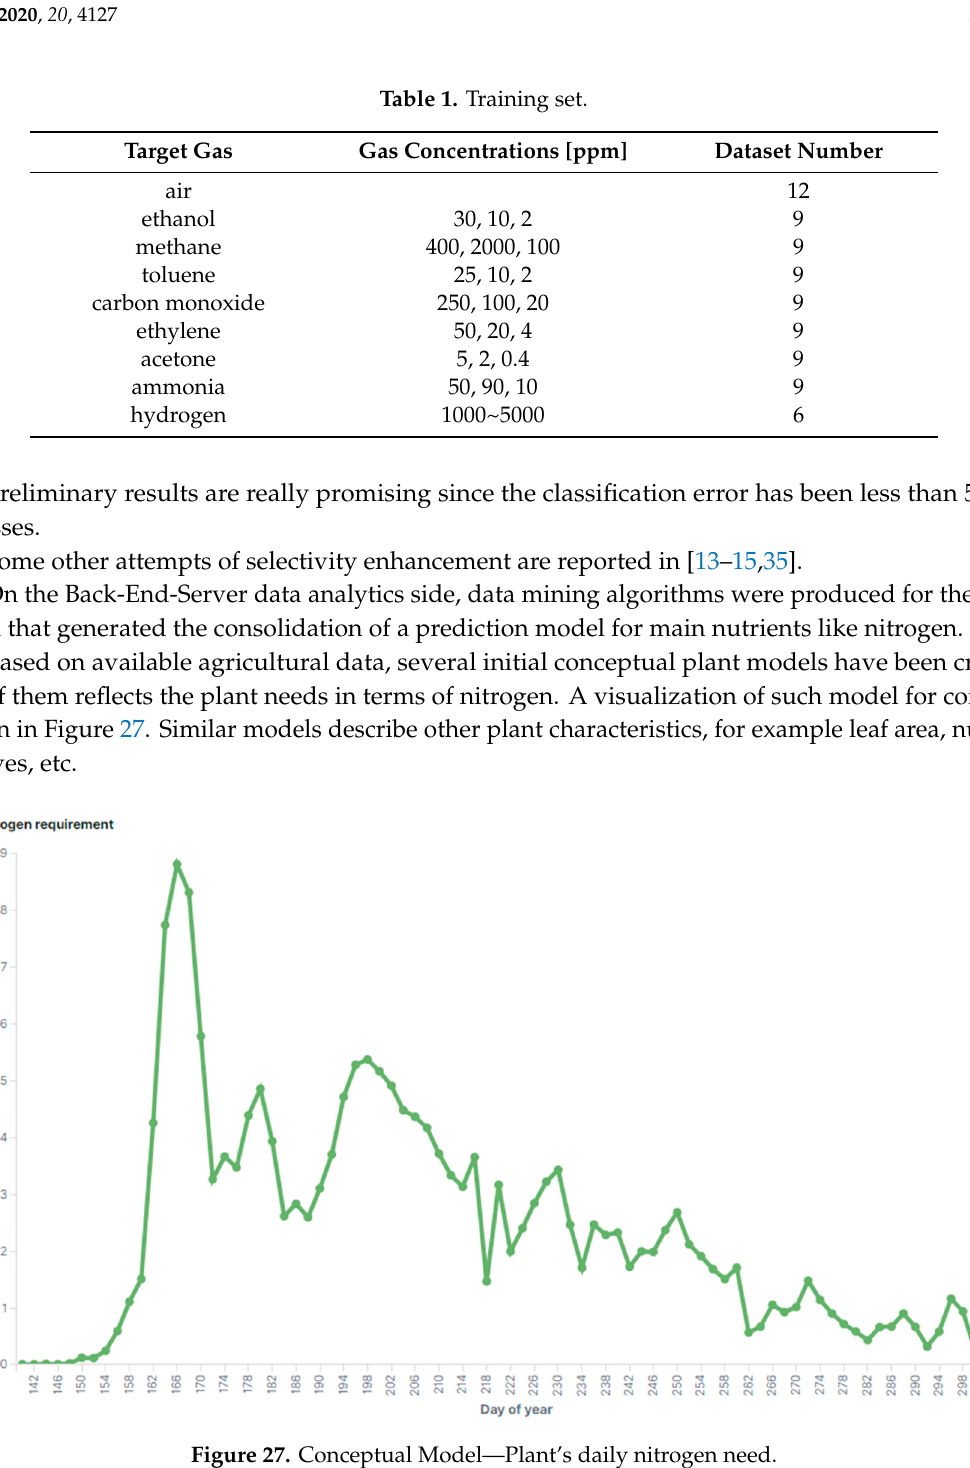
Figure 28. Maize growth stages [36].